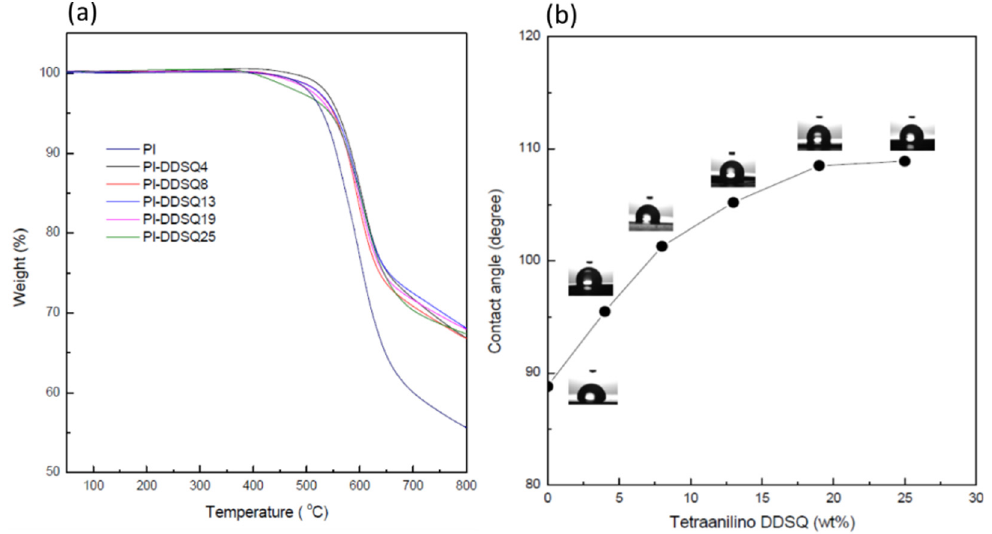
Figure 10. ( a ) Thermogravimetric analysis (TGA) thermogram and ( b ) water contact angles of PIs containing various contents of 5,11,14,17-tetranilino DDSQ [81]. Reproduced with permission from Wiley.